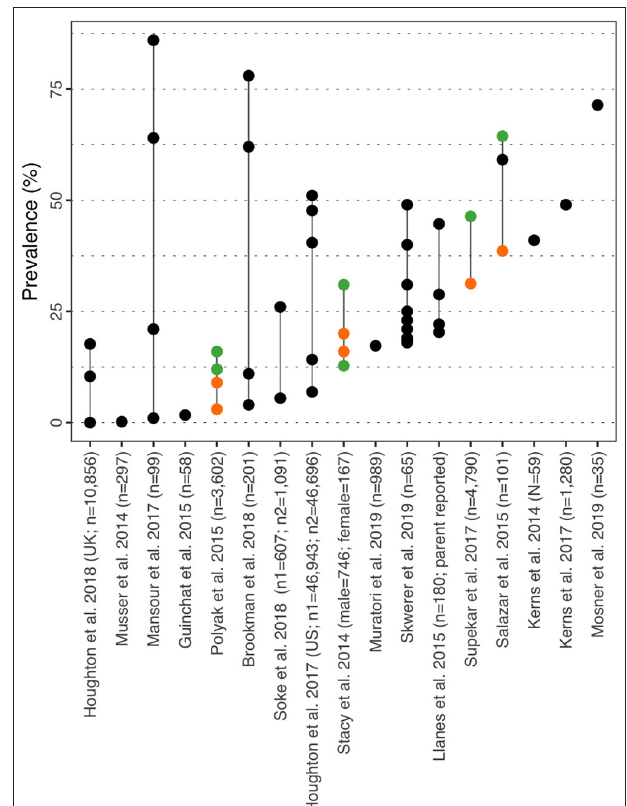
FIGURE 3 | ADHD prevalence estimates. Each point reports a prevalence estimate for the related comorbidity. Studies with more than one data point indicate the estimate of the prevalence among different subgroup of the population. See Supplementary Table 4 for the description of the population used in each study. Sample sizes are shown in brackets above each study label. Orange mark: Female population only; Green mark: Male population only; Black mark: No sex